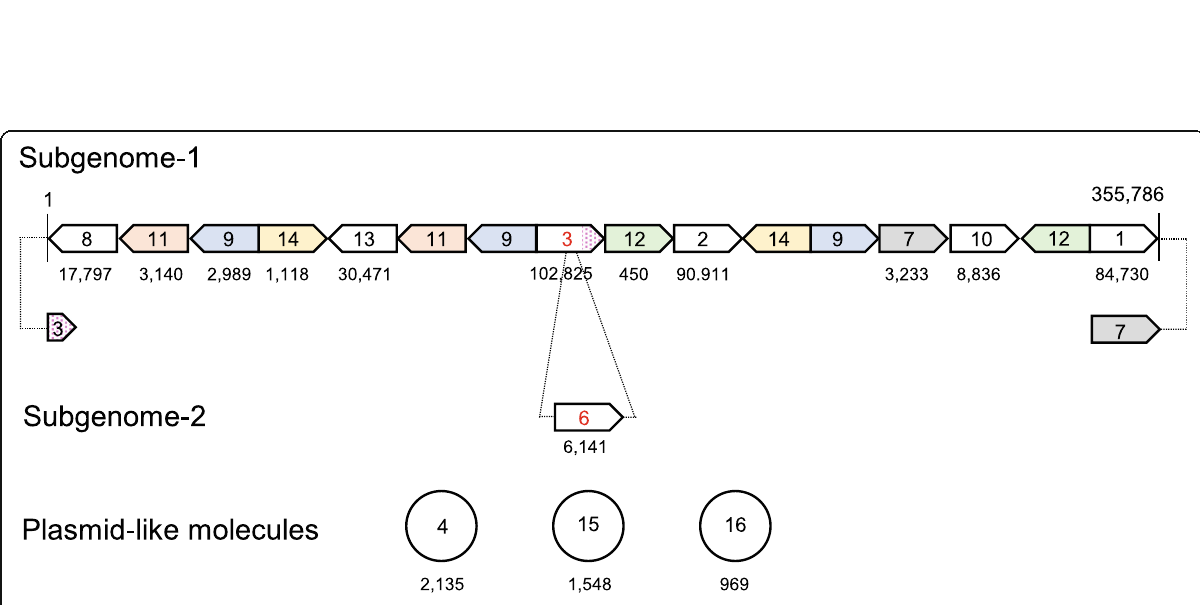
Fig. 2 Configuration of contigs in the TAA mitochondrial genome. The same contigs are indicated by the same colors. Numbers within the boxes and circles indicate the names of contigs, and the numbers below each box and circle indicate the contig lengths. Box and circle sizes are not to scale. Connections of the end of subgenome-1 and subgenome-2 are indicated by dotted